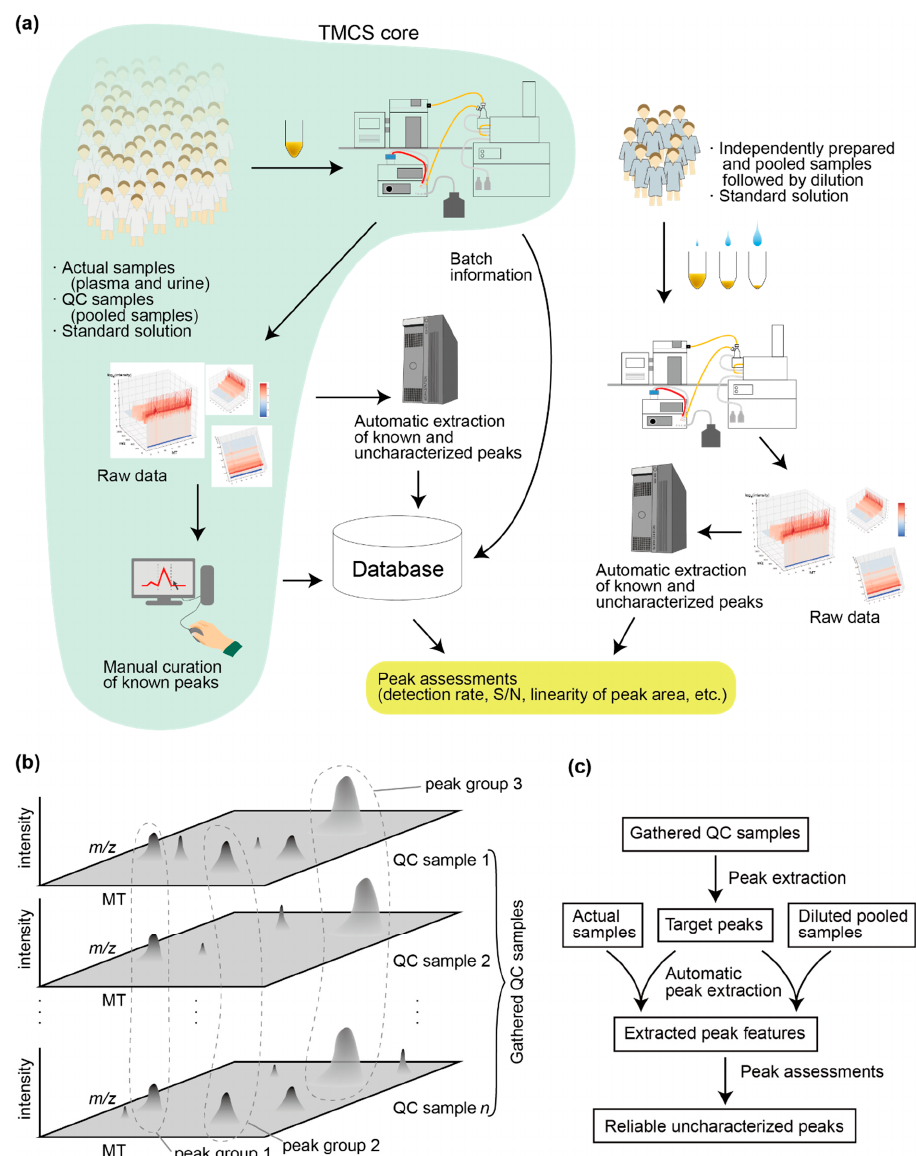
Figure 1. Overview of the pipeline used in the present study and determination of target peaks. ( a ) Overview of the data collection and peak processing/extraction pipeline. The routine used in the Tsuruoka Metabolome Cohort Study (TMCS) is labeled as “TMCS core”. The other procedures are specific to the present study. In the TMCS routine, the characterized peaks are manually curated, whereas in the present study, the peaks were processed automatically. ( b ) Determination of target peaks using 30 randomly selected quality control (QC) samples. The peaks in the 30 gathered QC samples were aligned and clustered to form “peak groups” that had similar m/z and migration times (MTs). Ideally, each peak will correspond to a specific metabolite. ( c ) Overview of the peak processing/extraction pipeline focusing on the data flow for filtering reliable uncharacterized peaks. Our proprietary software MasterHands was used for peak extraction.